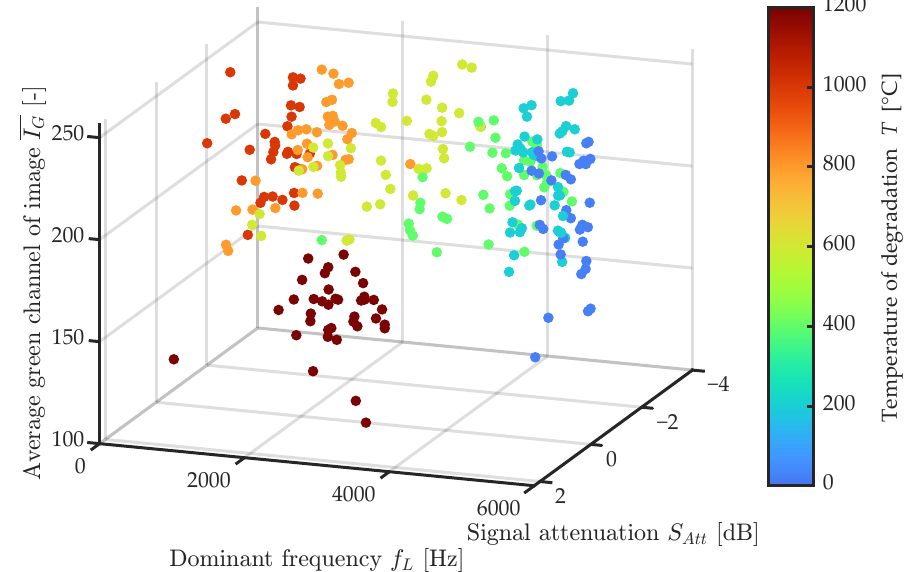
Figure 16. Comparison of dependency between green channel average value, dominant frequency f L , and signal